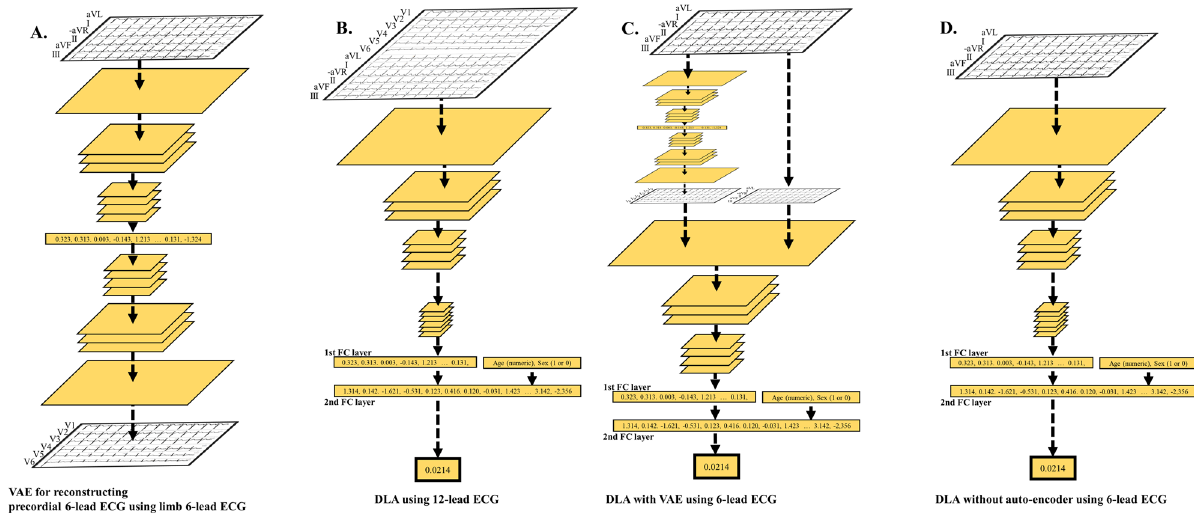
myocardial infarction, VAE variational